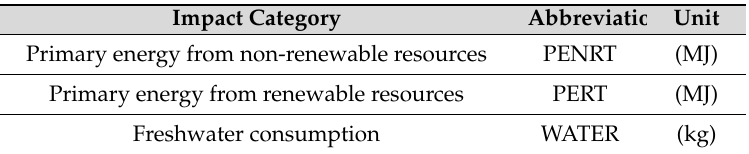
Table 2. The primary energy demand and the total use of freshwater potentials.